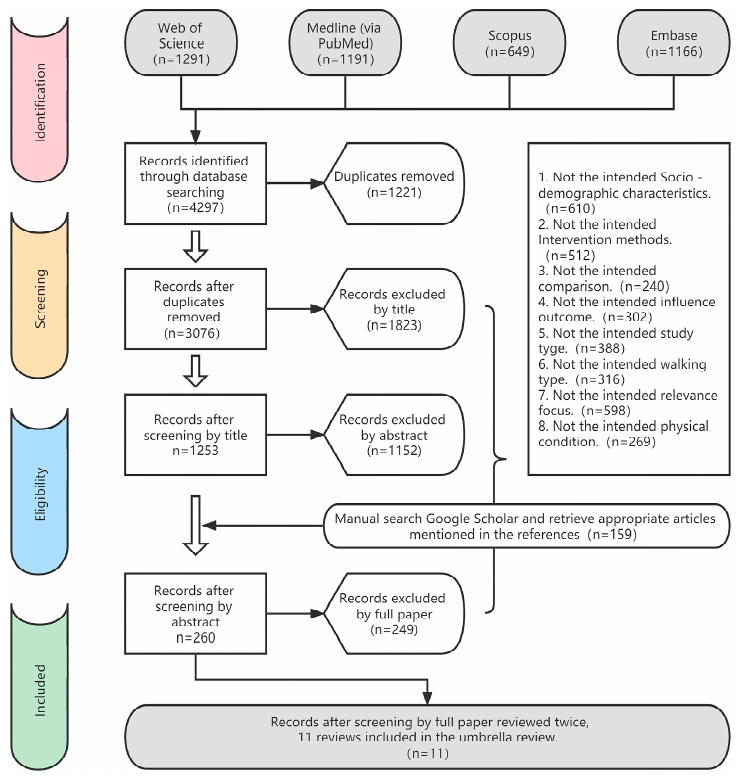
Figure 1. The procedure was followed using the PRISMA